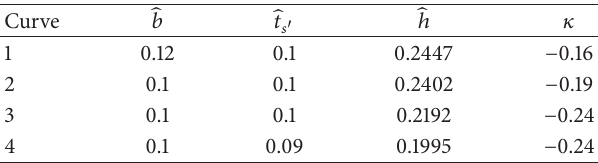
Table 1: The configurative parameters of the QZS isolator satisfying the optimization criteria.